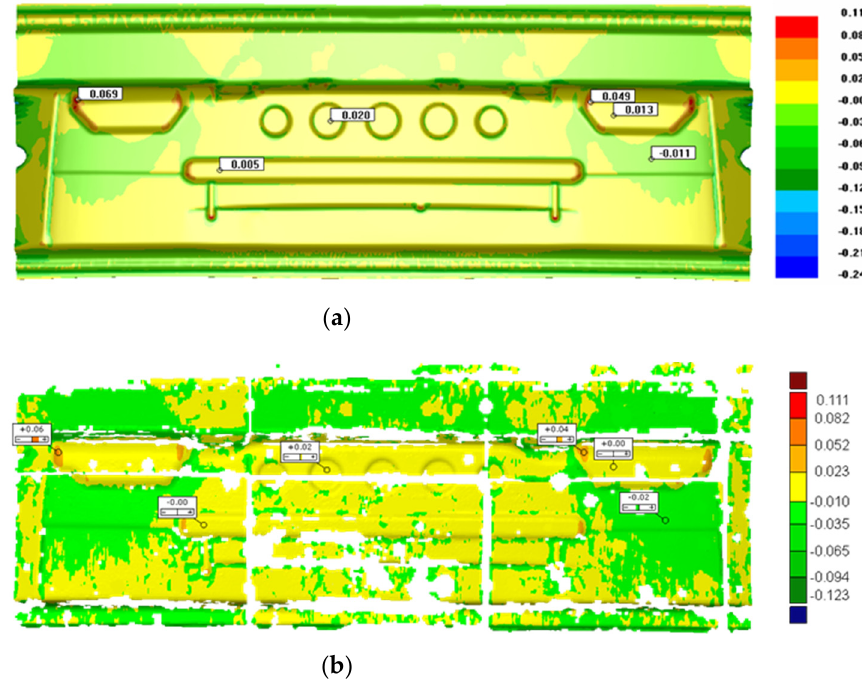
Figure 16. Results of the minor strain obtained by ( a ) simulation and ( b ) experiment.